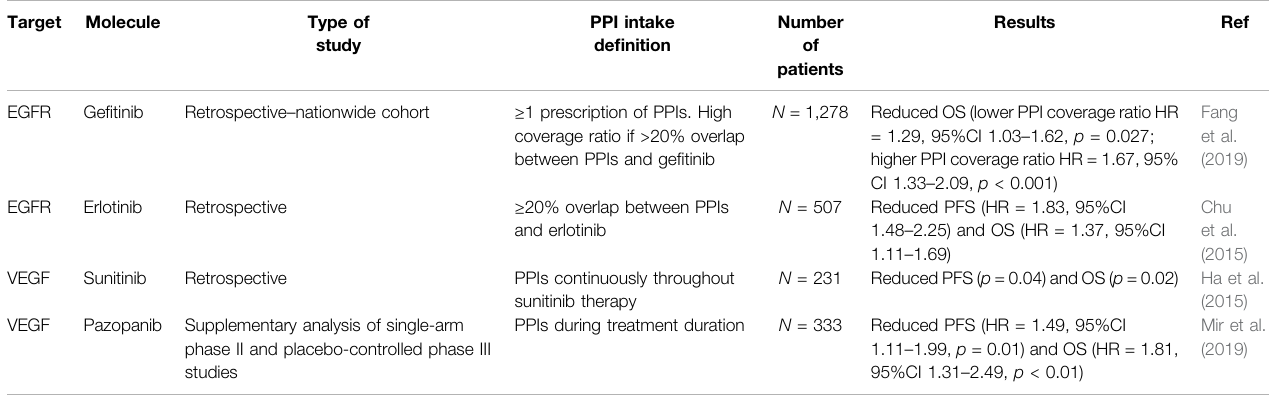
TABLE 4 | Main studies reporting a decrease in survival of patients receiving proton pump inhibitors with tyrosine kinase inhibitors. Target